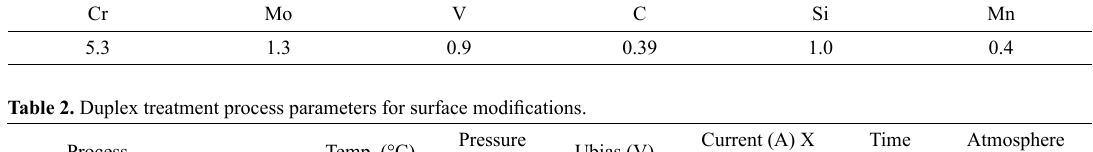
Table 1. Chemical composition analyses of the AISI H13 tool steel substrates (wt.%, balance Fe). Cr